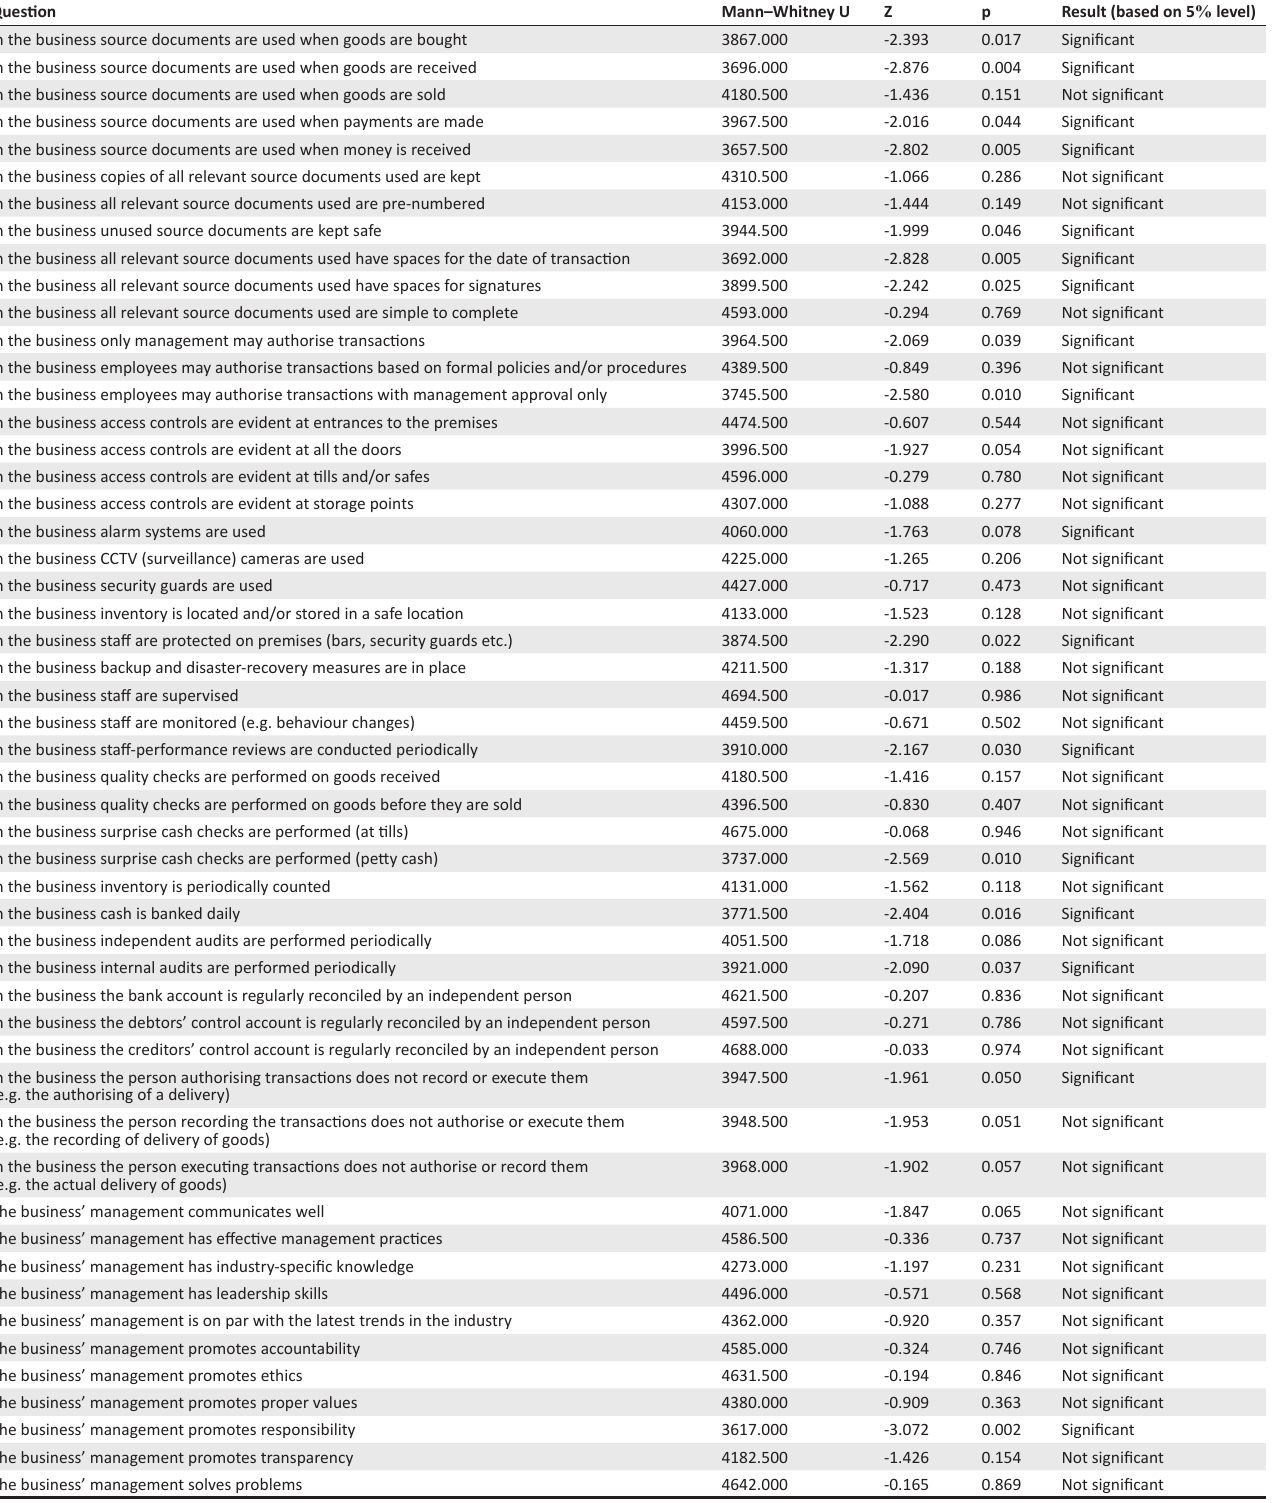
TABLE 1-A3: Significant differences between the views of members of management and